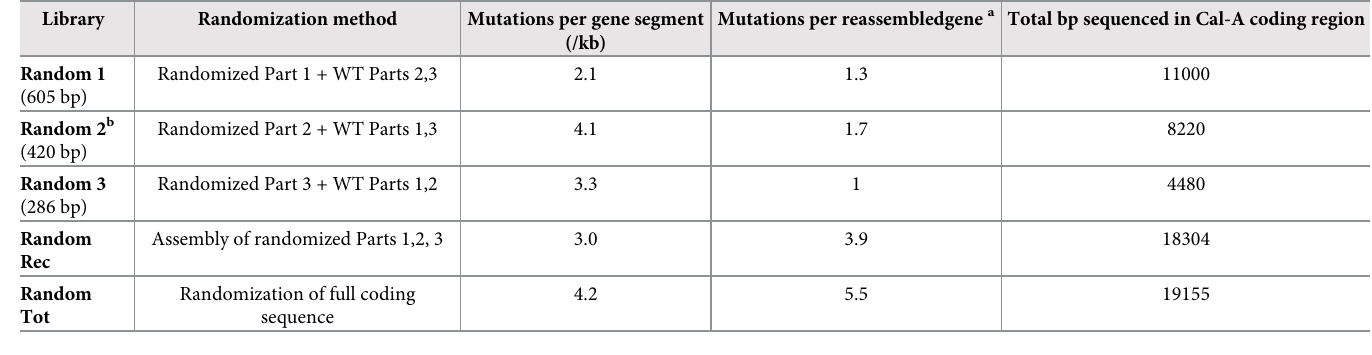
Table 1. Library generation and assessment of library